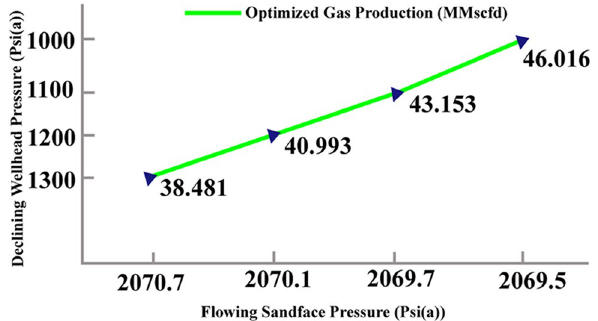
Fig. 4 The optimized gas production rate of the